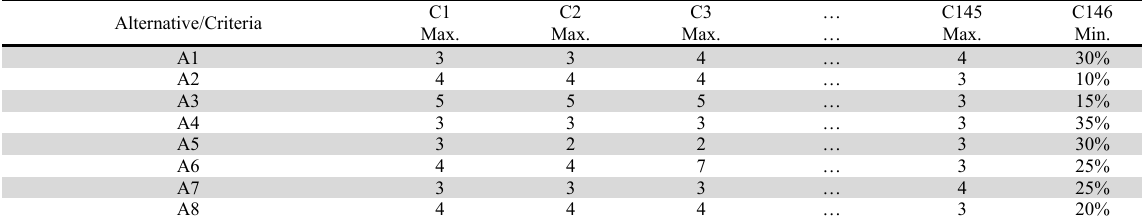
Input decision-making matrix Alternative/Criteria